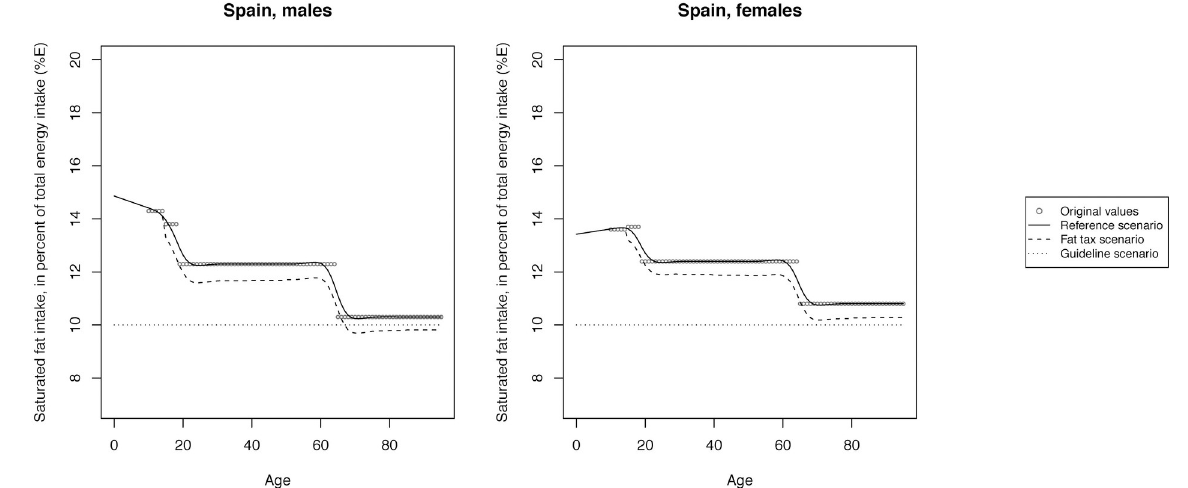
Fig 6. Mean saturated fat intake across reference, fat tax and guideline scenario in